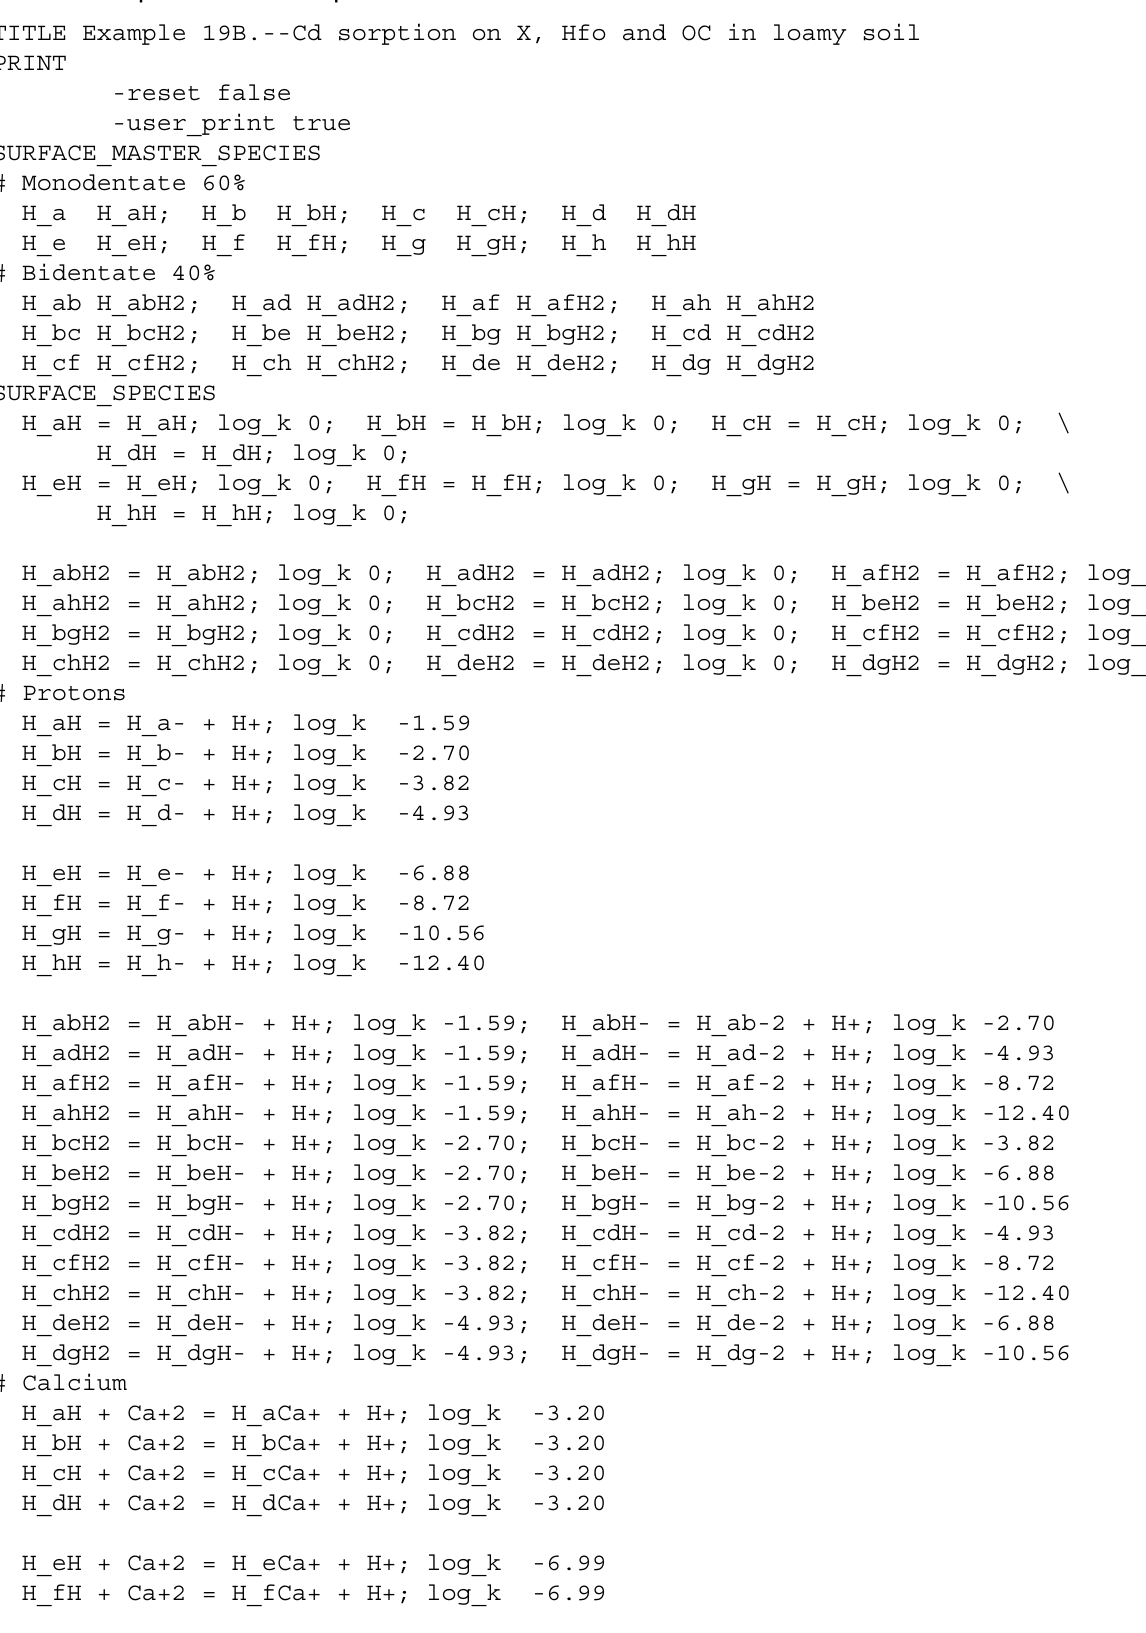
Table 56. Input file for example